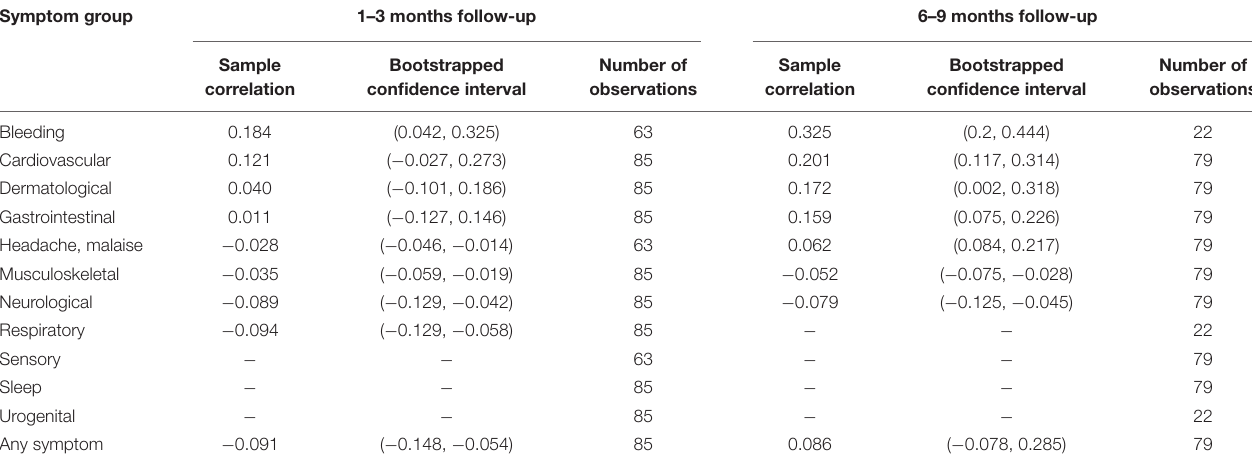
TABLE 5 | Correlation of symptoms between children and adult family members in the same household. Symptom